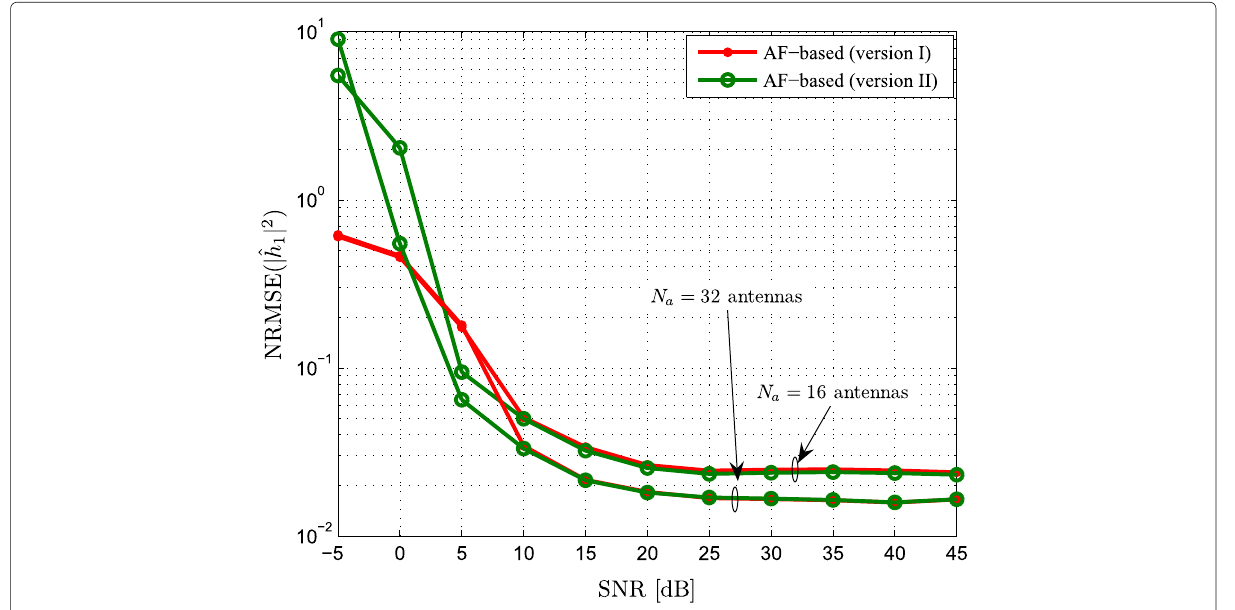
Fig. 8 NRMSE of the channel power estimators ( versionsI and II ) with N = 10, θ 1 = 18°, θ 2 = 36°, K = 2, N a = 16, 32, and σ 2 =